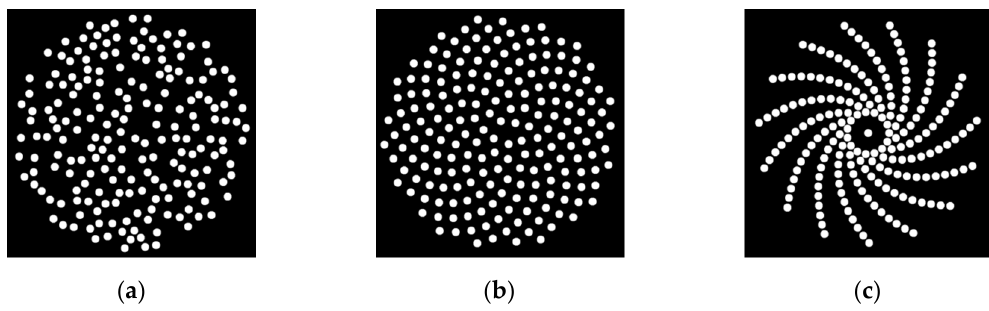
Figure 1. Three sparse array configurations which have been simulated in this work: ( a ) random array; ( b ) sunflower spiral array; ( c ) log spiral array.